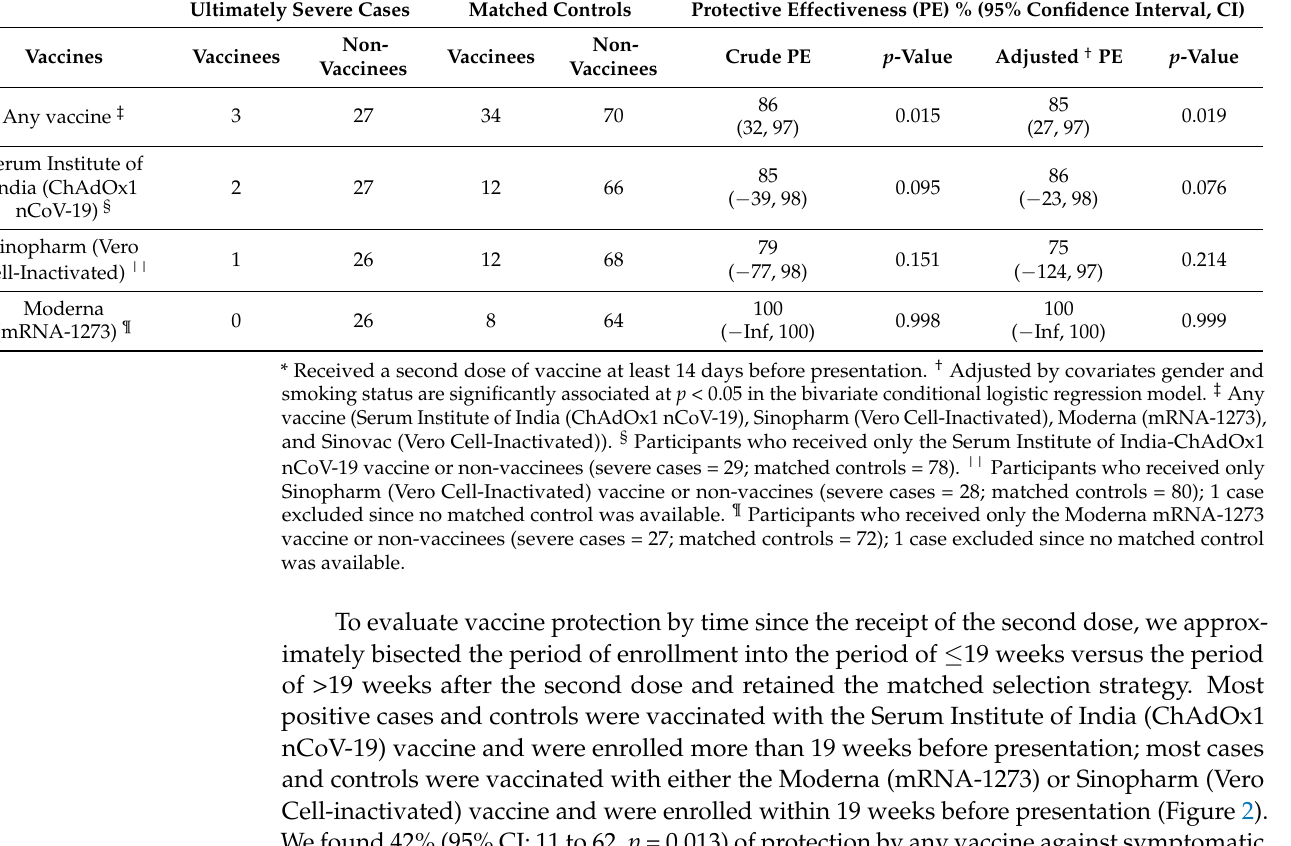
Table 3. Protection against ultimate severe COVID-19 disease by the receipt of complete regimens of vaccines *.